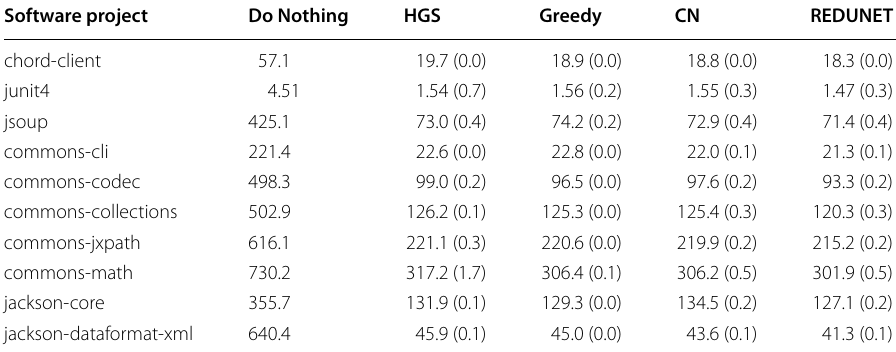
The numbers within brackets represent the time for computing the test suite optimisation (see also Fig.